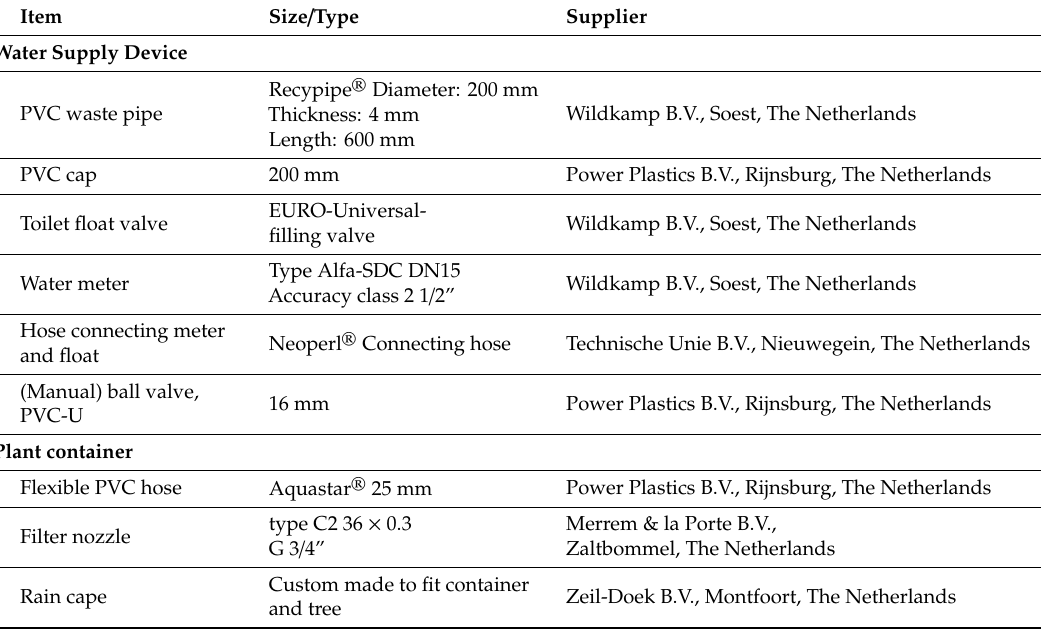
Table 1. Materials used for constructing the water supply device and preparing the plant